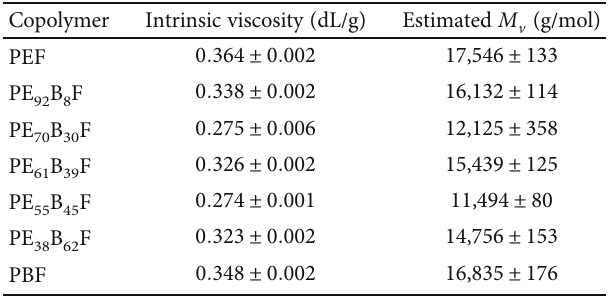
Table 3: Intrinsic viscosities and estimated average of